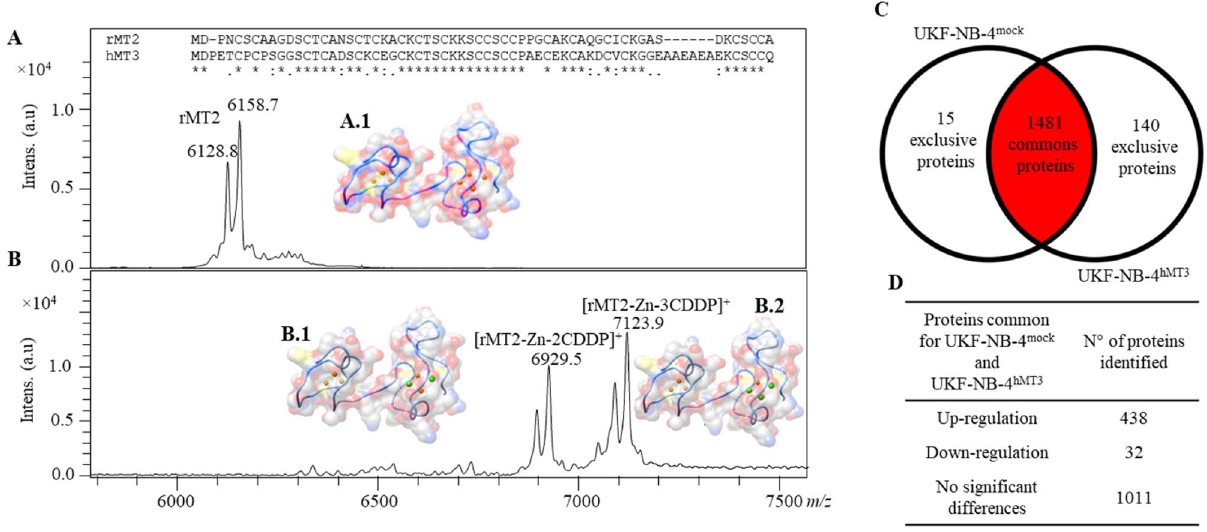
Figure 4. MALDI-TOF mass spectra of rMT2-CDDP complex and purified rMT2 standard. Upper insert shows CLUSTAL multiple sequence alignment of rabbit rMT2 and hMT3. Amino acid from the sequences with asterisk (*) indicate 100% of similarity between rMT2 and hMT3. ( A ) MALDI-TOF spectra of rMT2 and ( B ) complex between rMT2 and CDDP after 24 h incubation in PBS (pH 7.5). Each spectrum was averaged from 2000 subspectra. In each mass spectrum, the hypothetical models of hMT3 complexed with Zn and Pt are shown. hMT3 protein sequence (P25713) was used to build a homology model based on template structure of rat MT2 (PDB ID 4MT2) via SwissModel server. Assuming that superior electronegativity of Pt ions replaced Zn in a similar fashion to Cd ions, the 3D structures of hMT3 Pt/Zn complexes are shown here. ( A.1 ) Zn7-MT3 and ( B.1 ) Pt2Zn5-hMT3 and (B.2) Pt3Zn4-hMT3. hMT3 is shown in blue ribbon and molecular surface HETATOM colours. Zn and Pt ions are shown in orange and green, respectably. ( C ) Venn diagram